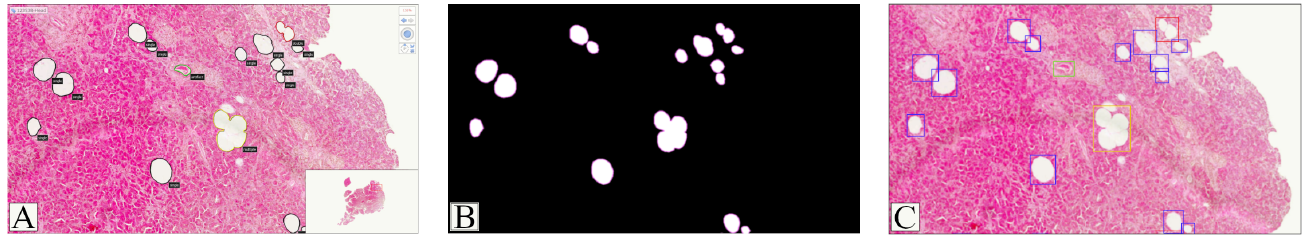
Figure 3. Visual representation of the histological objects annotation stage: ( A ) manual annotation of four pancreatic classes with the NDP.view2 software (black → “single”, red → “double”, yellow → “multiple”, green → “artifact”); ( B ) extraction of the ground truth binary fat image and calculation of the semi-quantitative steatosis prevalence in the biopsy sample; ( C ) determining the bounding box for all annotated regions and exporting them as image patches for applying transfer learning in pretrained CNN